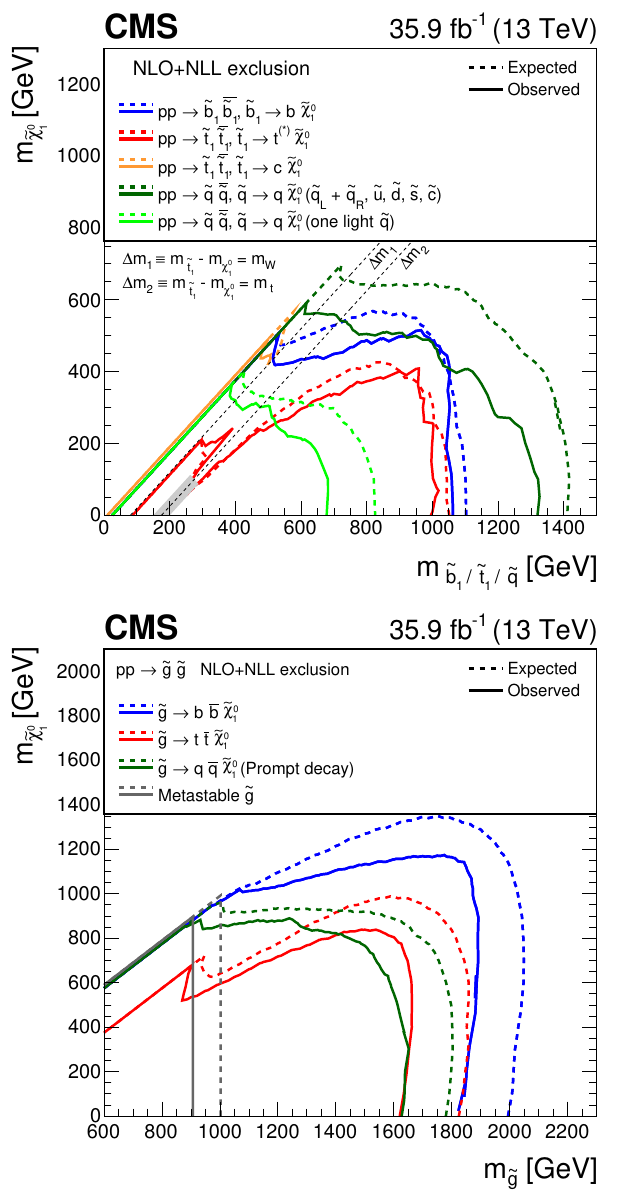
Figure 3 . Observed and expected mass exclusions at 95% CL (indicated, respectively, by solid and dashed contours) for various families of simpli(cid:12)ed models. The upper sub(cid:12)gure summarises the mass exclusions for (cid:12)ve model families that involve the direct pair production of squarks. The (cid:12)rst scenario considers the pair production and decay of bottom squarks (T2bb). Two scenarios involve the production and decay of top squark pairs (T2tt and T2cc). The grey shaded region denotes T2tt models that are not considered for interpretation. Two further scenarios involve, respectively, the production and decay of light-(cid:13)avour squarks, with di(cid:11)erent assumptions on the mass degeneracy of the squarks as described in the text (T2qq 8fold and T2qq 1fold). The lower sub(cid:12)gure summarises three scenarios that involve the production and prompt decay of gluino pairs via virtual squarks (T1bbbb, T1tttt, and T1qqqq). A (cid:12)nal scenario involves the production of gluinos that are assumed to be metastable on the detector scale